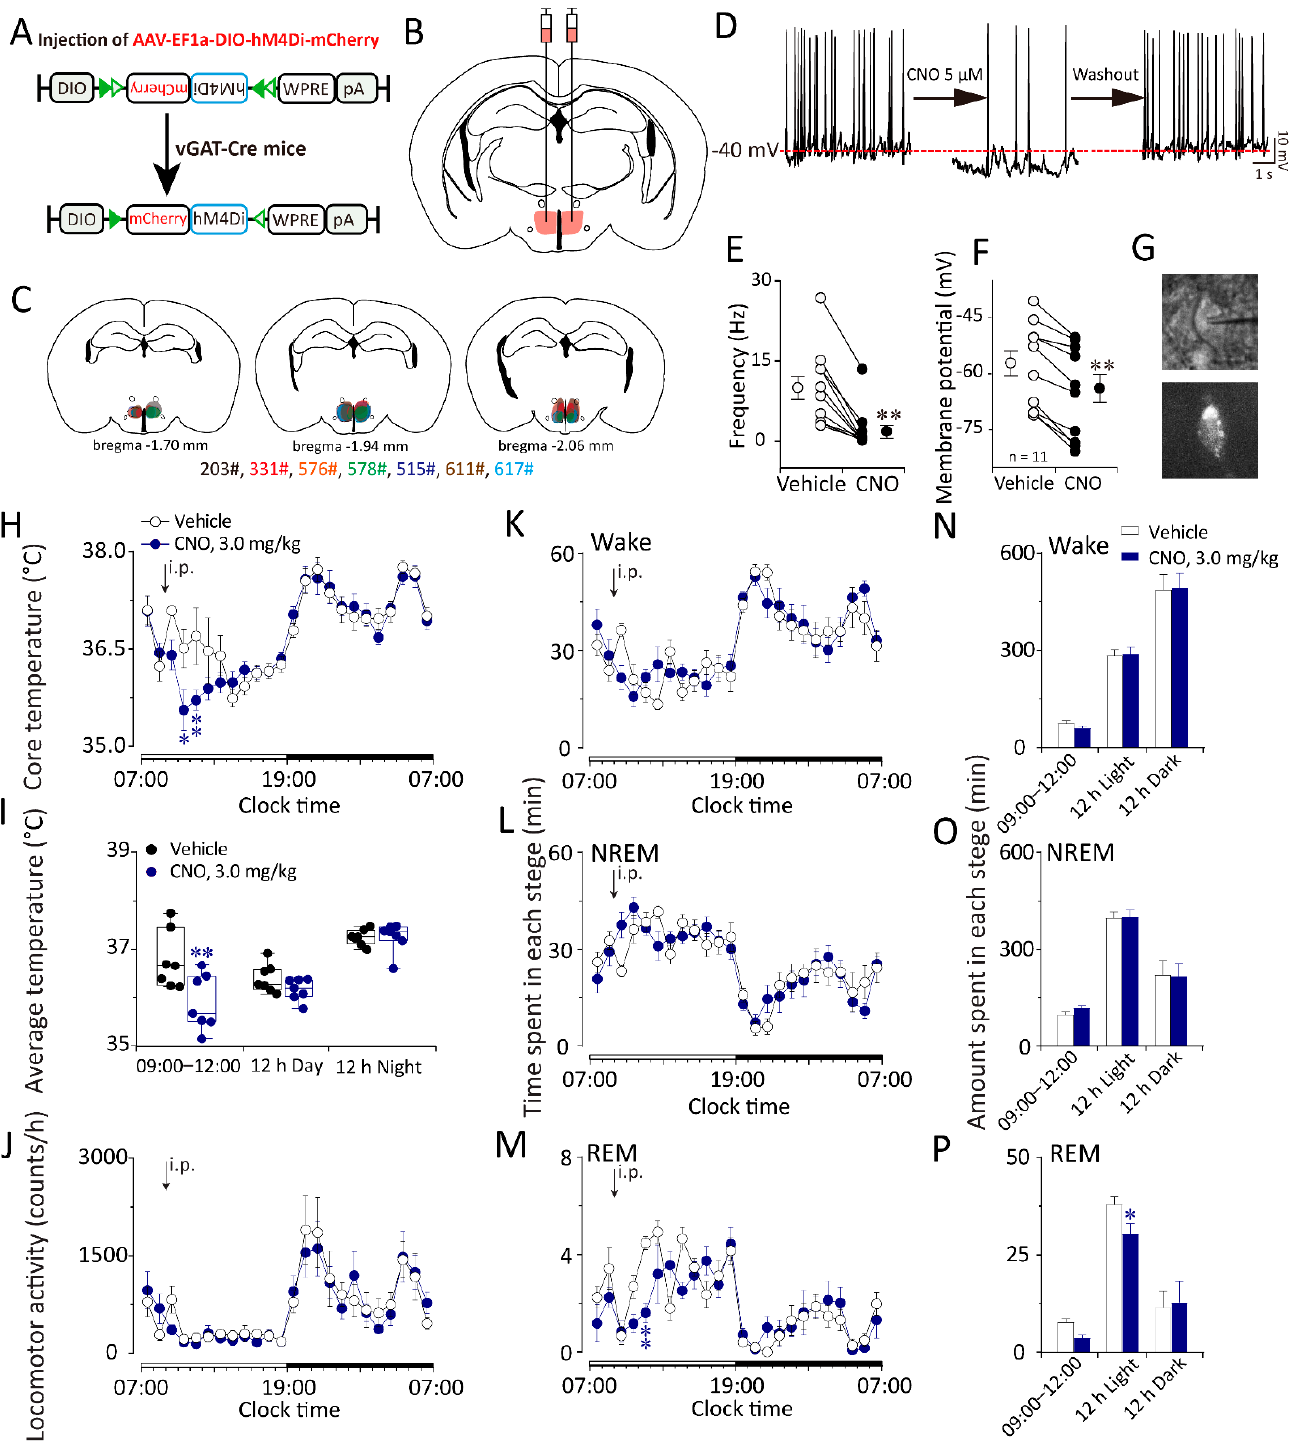
Figure 8. Chemogenetic inhibition of DMH GABAergic neurons lower the core temperature but did not affect sleep–wake cycle in vGAT–Cre mice. ( A ) The schematic representation of the microinjection of AAV–DIO–hM4Di–mCherry into the DMH of vGAT–Cre mice. hM4Di: selective human muscarinic acetylcholine M4 receptor. ( B , C ) Drawings of superimposed AAV microinjection sites in the DMH of vGAT–Cre mice ( n = 8, indicated with different colors). ( D ) Bath application of CNO (5 μ M) reduced the spontaneous firing rate of GABAergic neurons expressing hM4Di receptors in the DMH. ( E ) The frequency of action potential firing before and after the administration of CNO (5 μ M). ( F ) The membrane potential before and after the administration of CNO (5 μ M). ( G ) The recorded neuron in phase contrast (the upper panel) and fluorescent (the lower panel) microscopes in